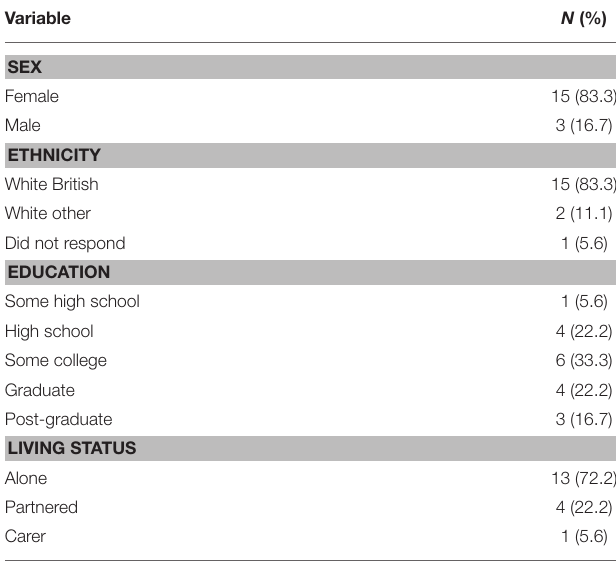
TABLE 1 | Demographic characteristics of the participants ( N =